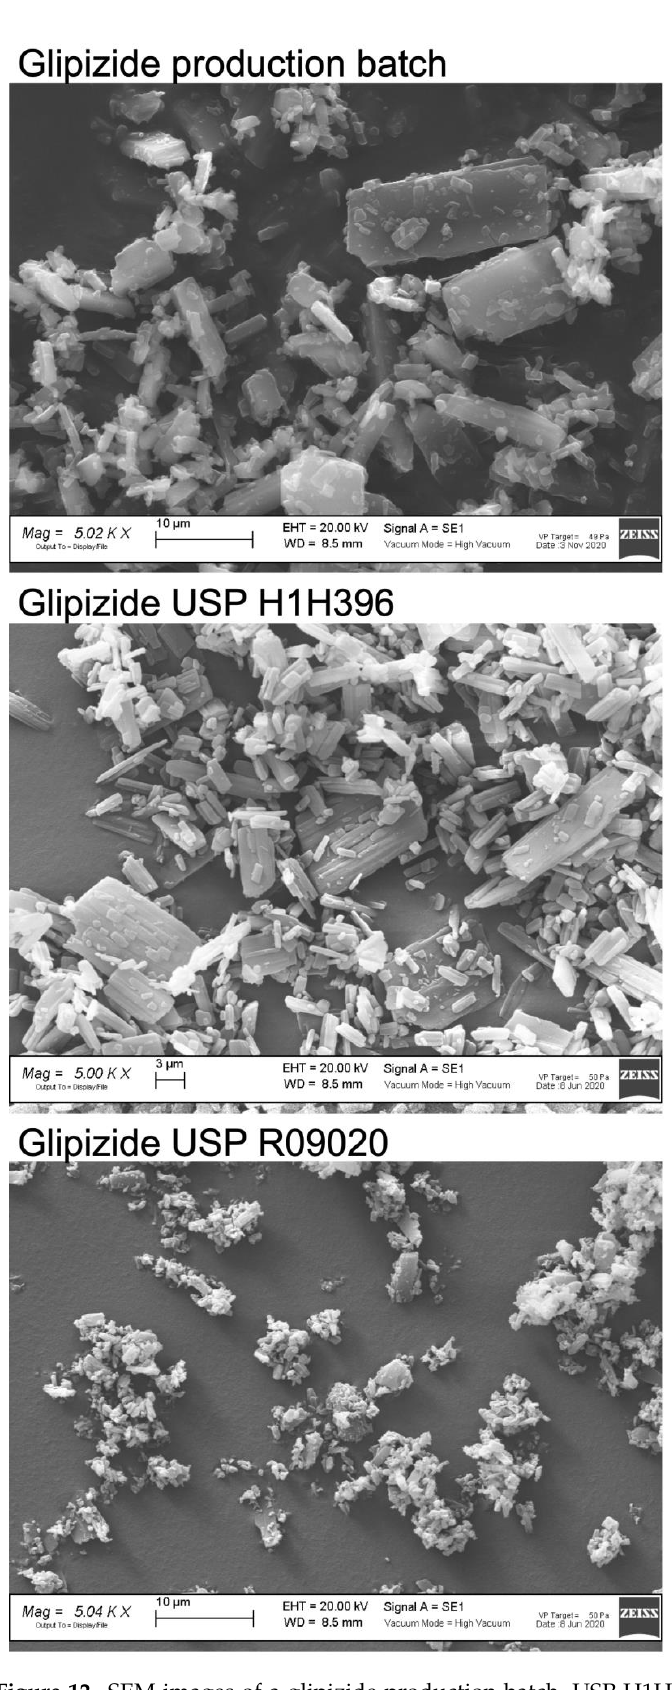
Figure 12. SEM images of a glipizide production batch, USP H1H396, and USP R09020 batches, 5000 ×